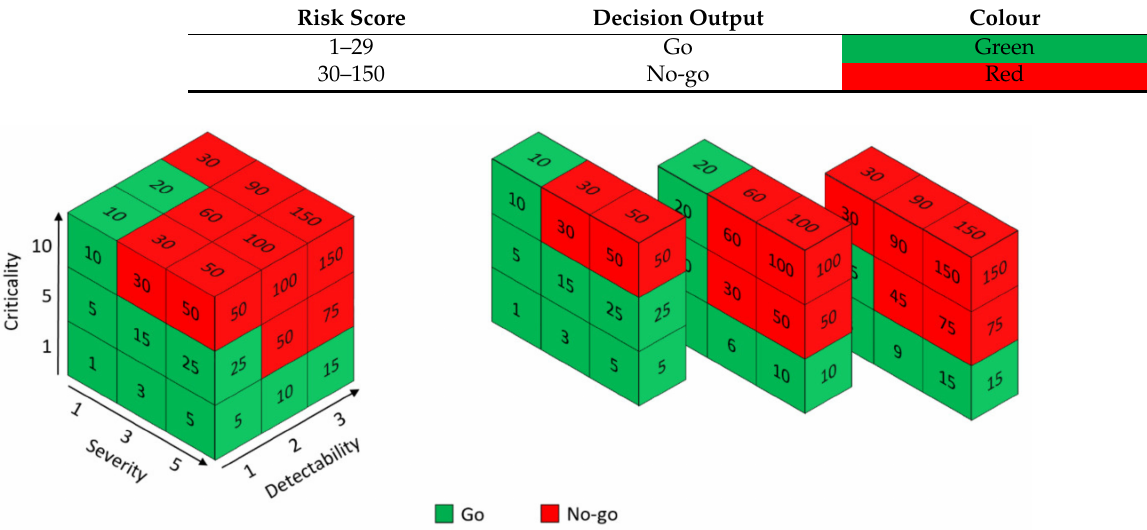
Table 12. Relationship between decision factor and decision output.